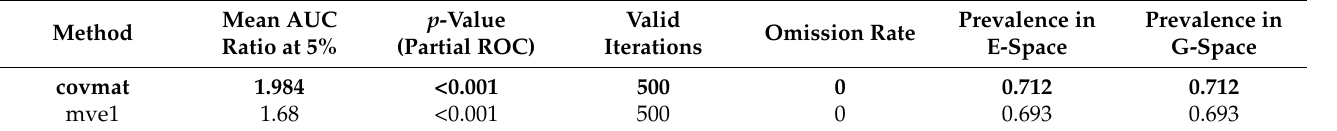
Table 3. Analysis of ellipsoidal niche overlap based on environmental conditions relevant for Lep- turges limpidus and Catostemma fragrans . Bioclimatic Variables